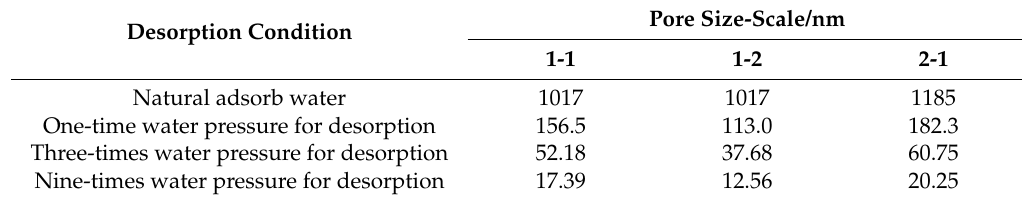
Figure 7. Contact angles for the two coal samples induced by water. ( a ) Coal Sample 1; ( b ) Coal Sample 2 Table 4. Critical pore sizes induced by water